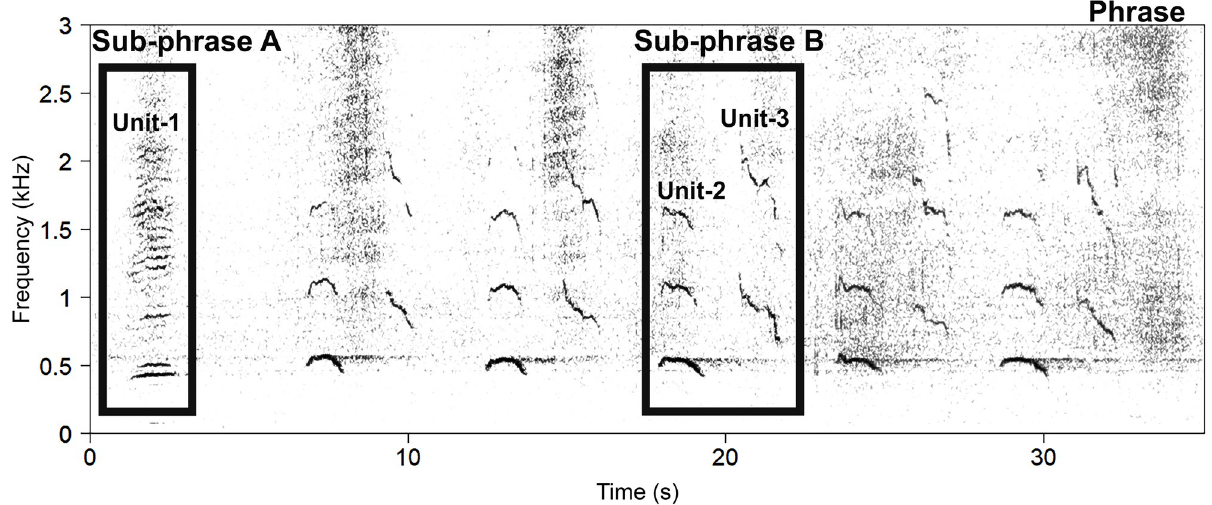
Fig 1. Spectrogram representation of a typical humpback whale song phrase observed during this study. This phrase is composed of two sub-phrase types (referred to here as A and B). Sub-phrase A is sung at the beginning of the phrase and is composed of a single unit. Sub-phrase B is composed of two different unit types and is repeated throughout the